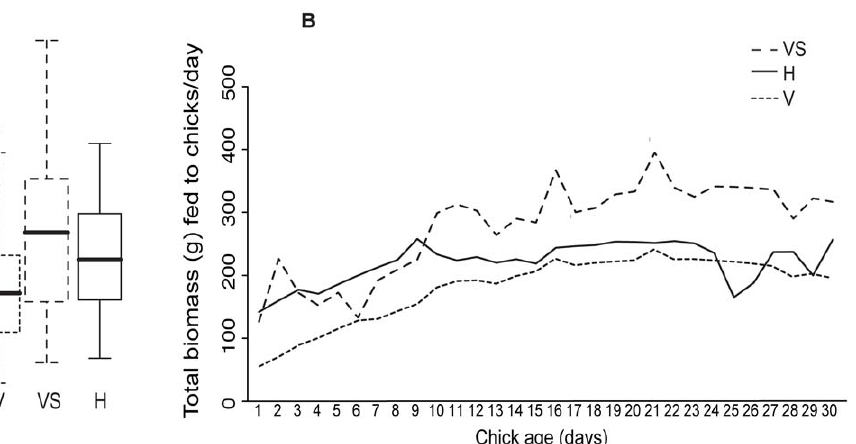
Figure 2. The total biomass of prey brought into nests in vineyards and hills. A The minimum, lower quartile, median, upper quartile, and maximum observations for vineyard nests with supplementary food items excluded (V), for vineyard nests including supplementary food items (VS) and for hill nests (H). B The fitted model estimates from a GLMM with a significant second order polynomial fitted for chick age, including supplementary food for vineyard nests (VS) and excluding supplementary food (V) and for hill nests (H). Model estimates indicated that as chick age increased falcons in vineyard nests brought in more total prey each day than did falcons in hill nests ( P , 0.001).